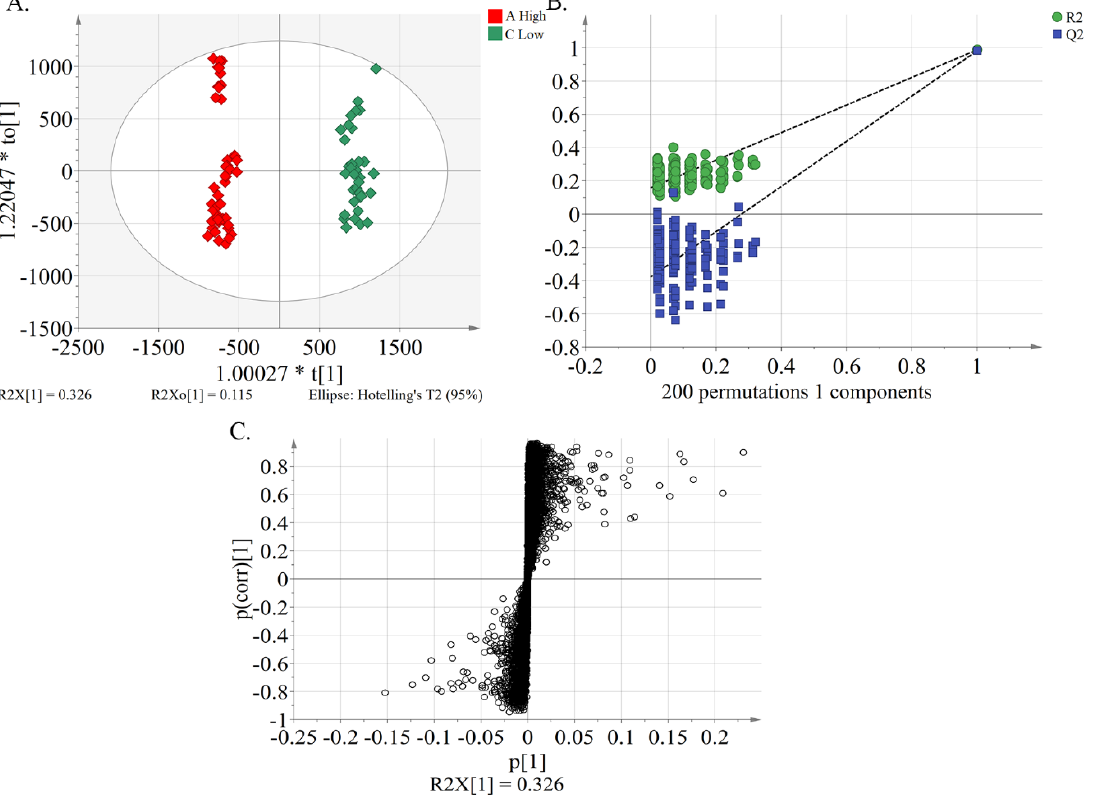
Figure 3. Multivariate statistical analysis of peach samples based on an OPLS-DA model. ( A ) OPLS-DA score plot showing the discrimination of the metabolome of peach cultivars between group A (IC 50 < 15) and group C (IC 50 ≥ 25). [R2Y(cum) = 0.988; Q2(cum) = 0.982]. ( B ) A presentation of chance permutation at 200 times used for the discrimination between group A and group C. [R2 = (0.0, 0.158); Q2 = (0.0, –0.378)]. ( C ) S-plot of OPLS-DA shows the di ff erential metabolite expression levels of peach pulp samples between group A and group C.